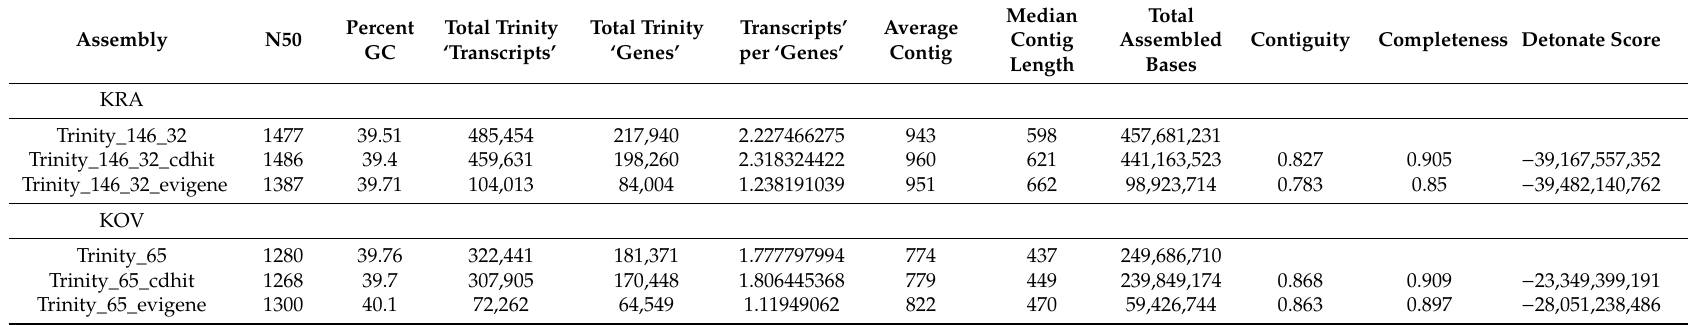
Table 2. Comparison of the KOV and KRA assemblies of S. vulgaris generated by Trinity and reduced by CD Hit and